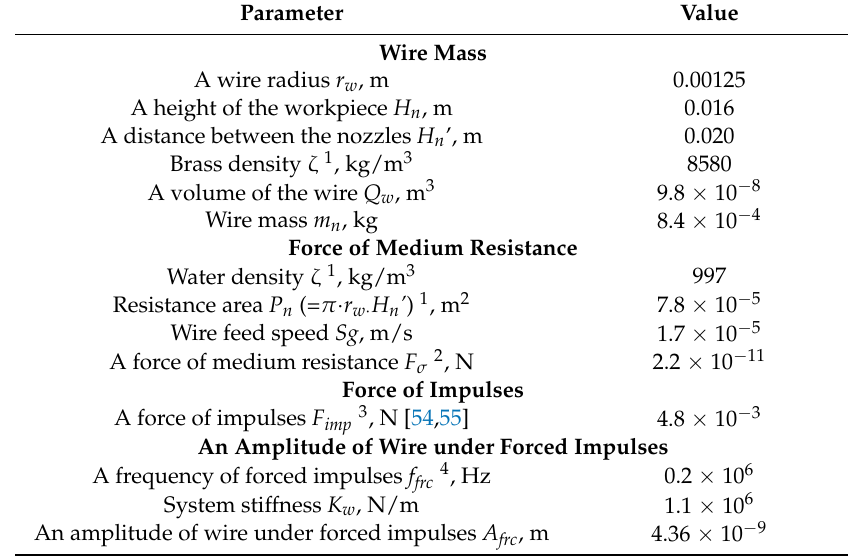
Table 3. Results of simplified mathematics for evaluation of wire amplitude under discharge impulses.